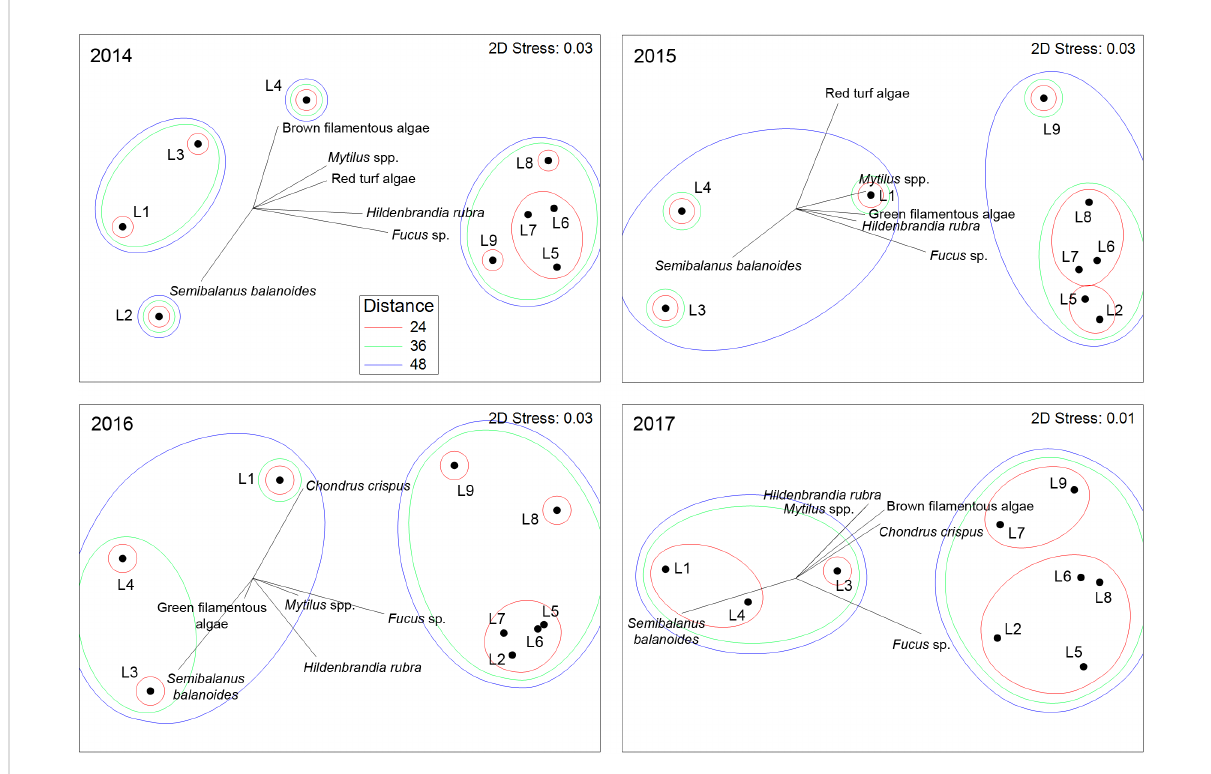
FIGURE 4 NMDS ordination plots for sessile species, showing the location centroids and vectors for the sessile species with the largest contribution to the multivariate patterns as revealed by SIMPER analyses. The shapes surrounding the centroids represent threshold Euclidean distances between the centroids.